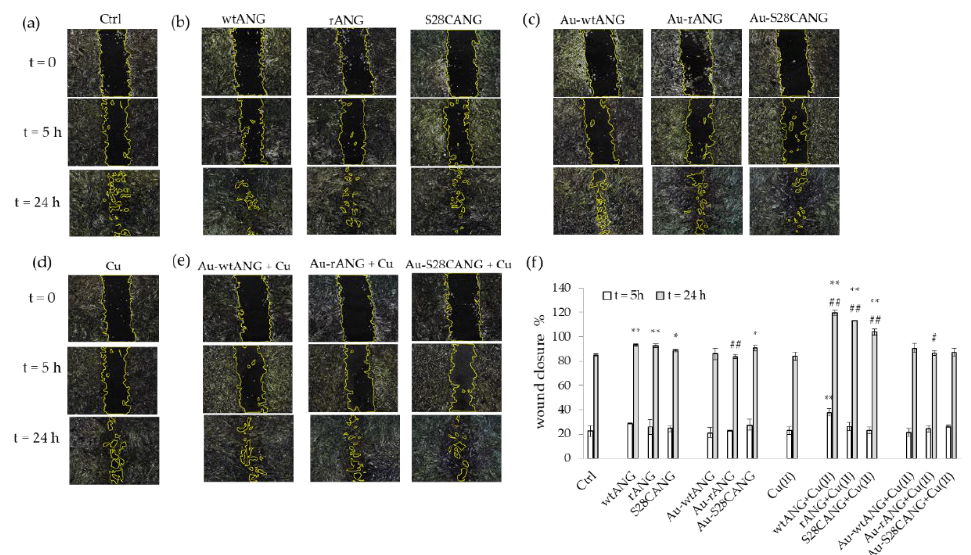
Figure 7. Representative micrographs of HUVECs, untreated ( a ): negative control) or treated with the different samples at time 0, 5 h and 24 h after scratch: ( b ) 20 nM free ANG proteins; ( c ) AuNP-ANG hybrids in the absence of copper; ( d ) 100 nM CuSO4; ( e ) AuNP-ANG hybrids in the presence of 100 nM CuSO4. The following nanoparticle concentrations were used: 0.2 nM Au-wtANG (2.77 × 106 NP/mL); 0.3 nM Au-rANG (2.32 × 107 NP/mL); 0.2 nM Au-S28CANG (1.96 × 106 NP/mL). In ( f ): quantitative analysis of migration assay (wound edge advancement in percent vs. time). Values (means ± SEM) are from three independent experiments. Statistical analysis was performed by pairwise Student’s T-test. (*) p < 0.05, (**) p < 0.01 vs. CTRL; (#) p < 0.05, (##) p < 0.01 vs. the corresponding free ANG protein. Results are expressed as percentage of wound closure with respect to time 0.